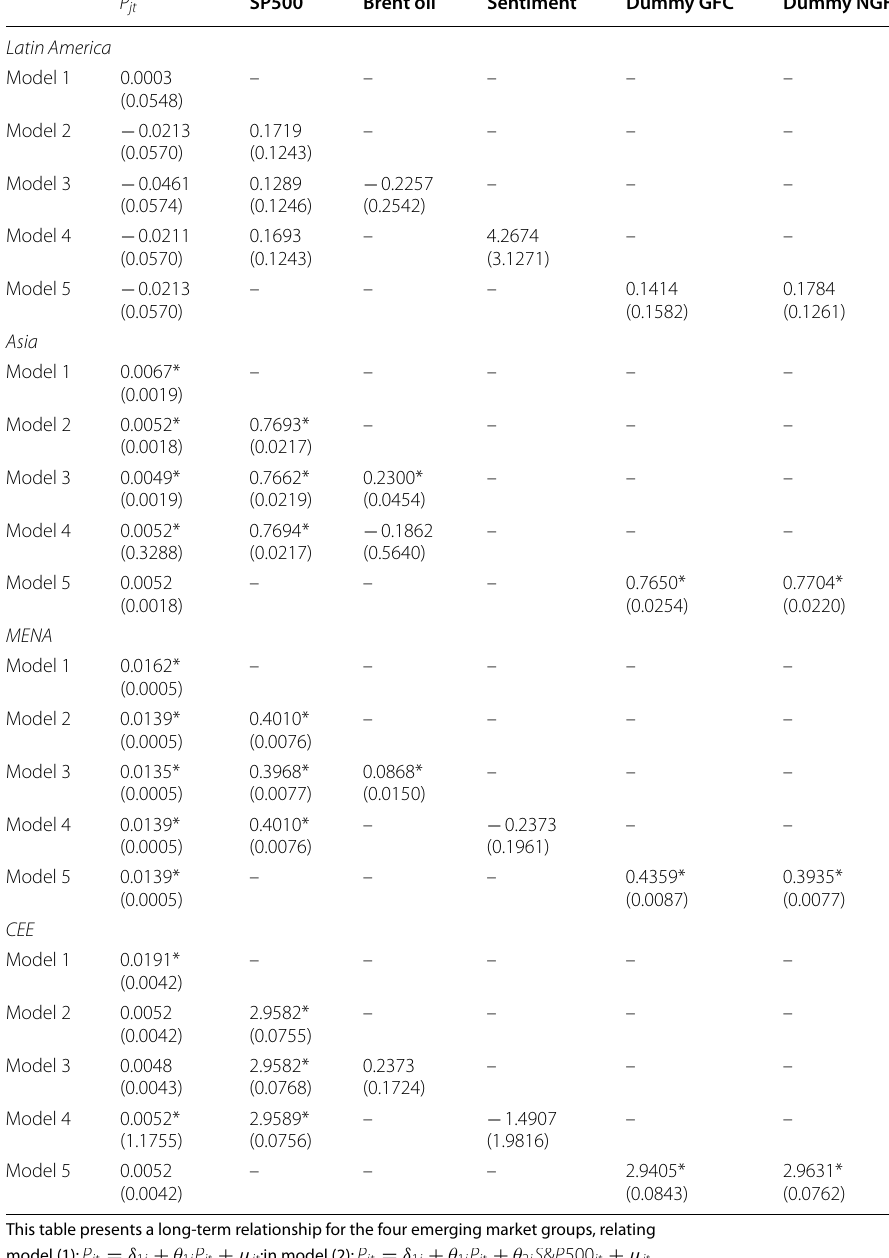
Table 5 Long‑term regression results: yellow international